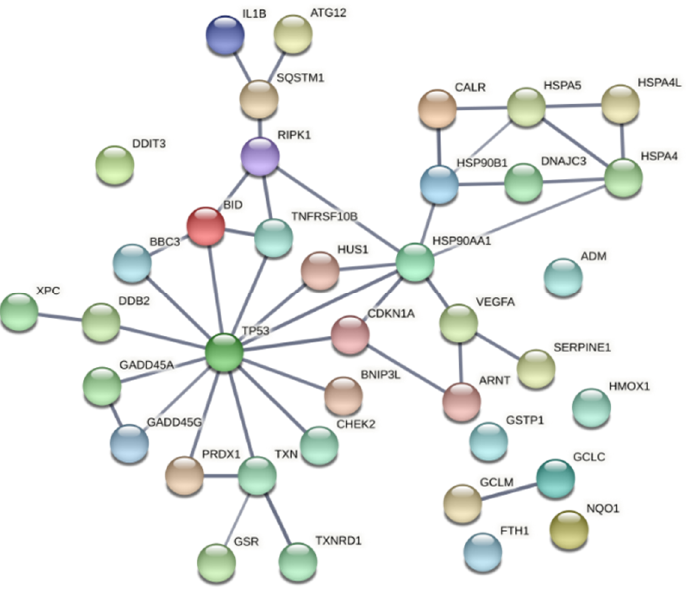
Figure 11. Functional associations between the tumor suppressor TP53 and the proteins encoded by genes with modified expression in PDT-treated HT29 tumor cells, as compared to non-treated cells (Table 2). The network was built using the online tool “STRING: functional protein association network”. Only connections deriving from experiments and databases, with a high confidence of 0.7, are